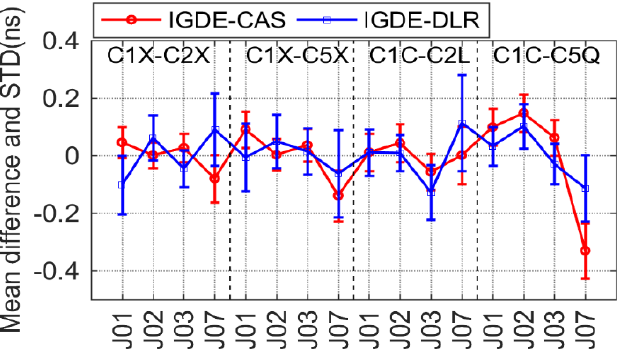
Figure 11. Mean difference and STD of QZSS DCB between IGDE and MGEX products. Table 2. Mean RMS value of all DCBs between IGDE and MGEX